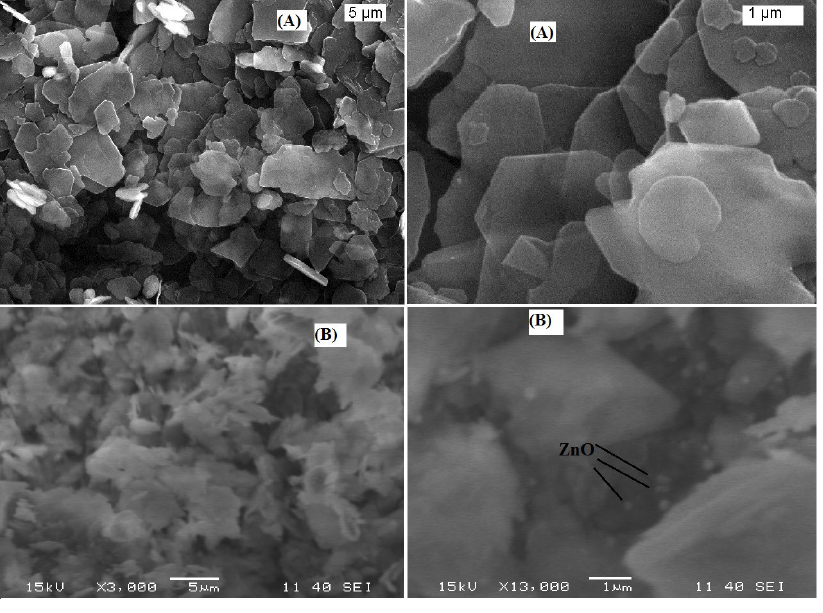
Fig. 4. SEM images of natural clay (A) and ZnO impregnated on clay